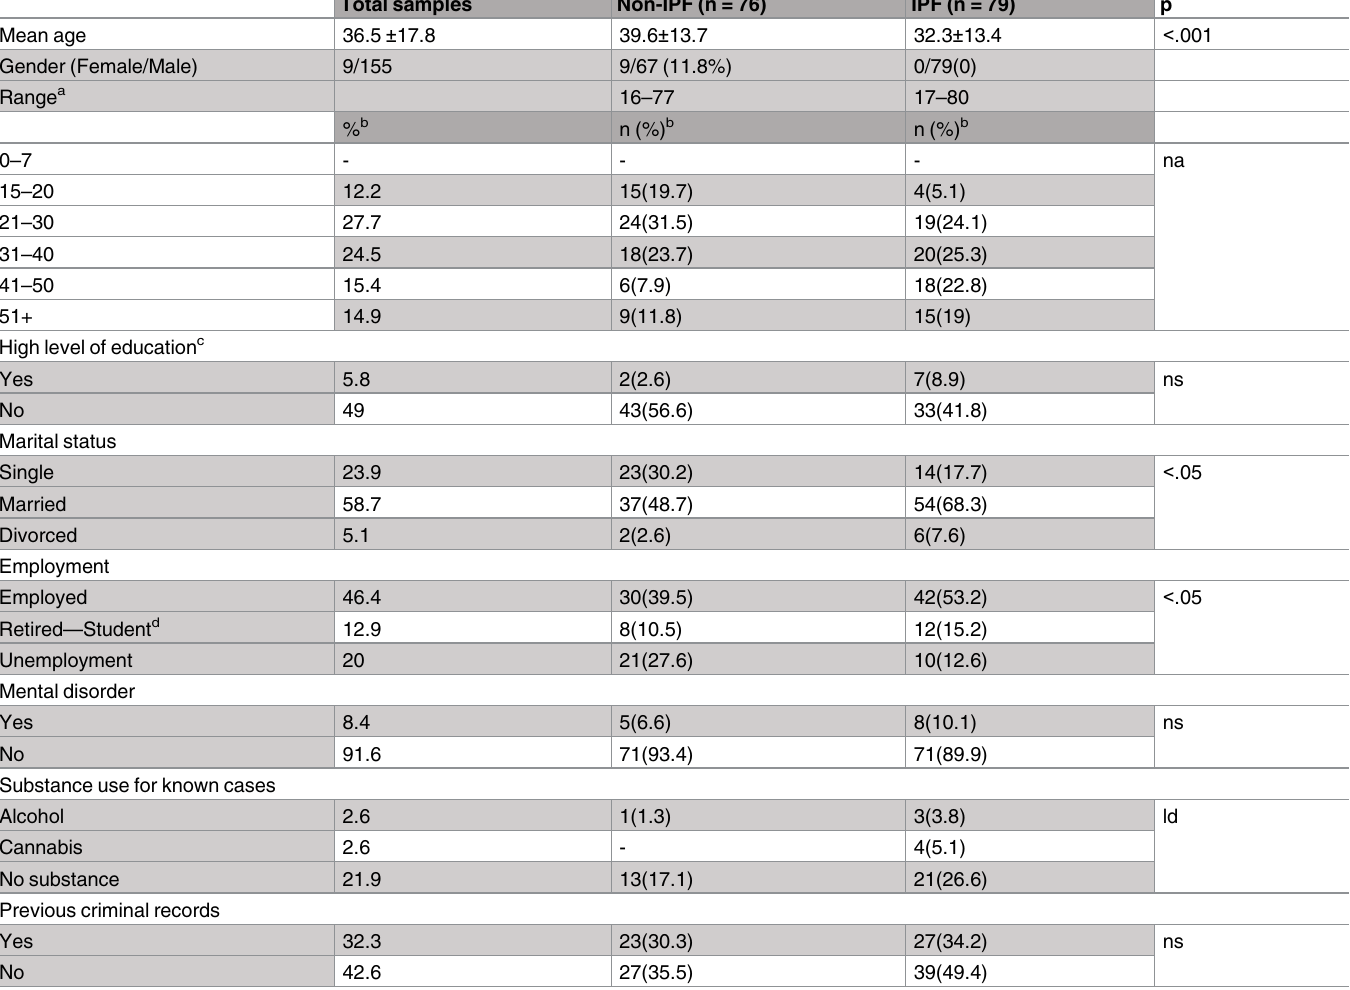
Table 1. Socio-demographic characteristics of perpetrators and general risk factors for homicide, by group. ld: not analyseddue to limited data; na: not analysed;ns: no significance. Total